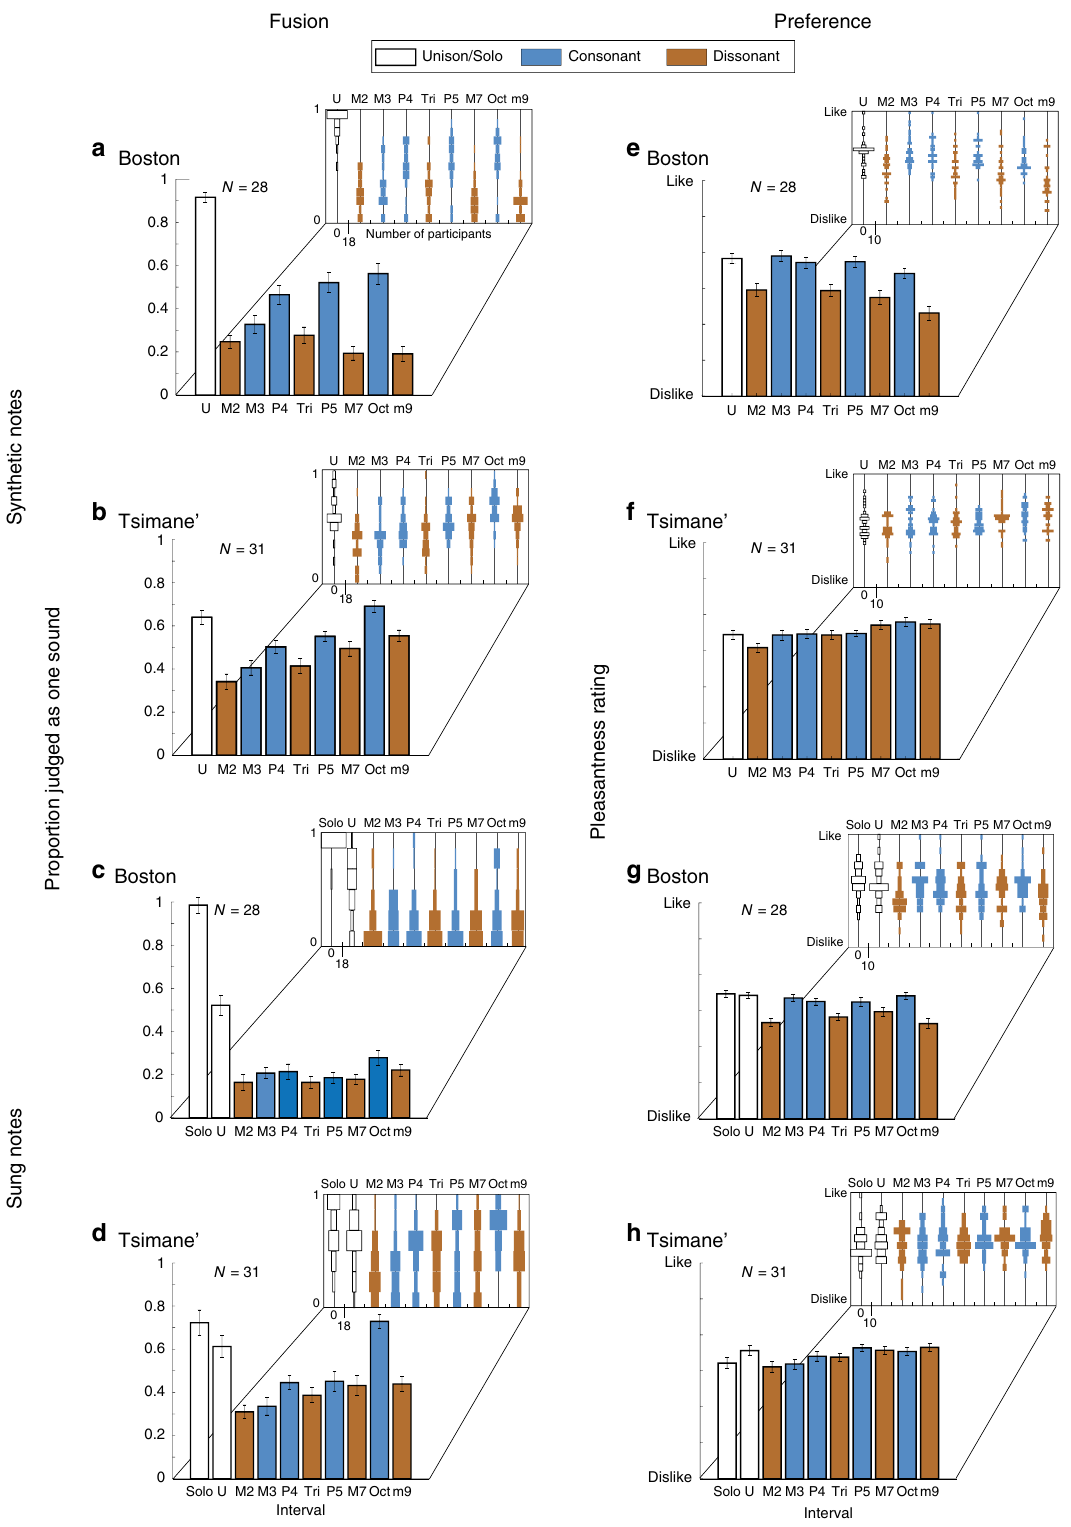
Fig. 3 In-person fusion and preference results separated by musical interval. a – d Proportion of stimuli judged as one sound. All bar plots show the mean ± SEM, except for panels ( d ) and ( h ) which plot the mean ± within-participant SEM. Insets show histograms of individual subject data for each condition. Due to the small number of trials per condition, and the small number of possible responses, there were a fi nite number of possible values for the average response for a participant. The histogram bins are matched to these values. Within each inset, the scaling of the histograms is matched across conditions, and this scaling is indicated once on the x -axis. e – h Average pleasantness ratings for each